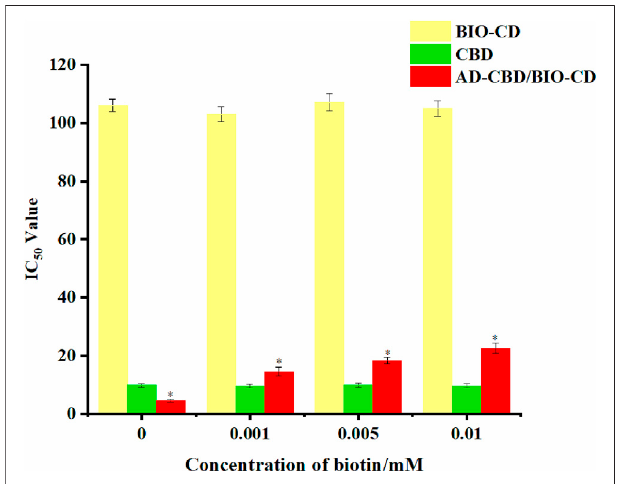
FIGURE 11 | IC 50 values of AD-CBD, BIO-CD, and AD-CBD/BIO-CD towards A549 cell lines under different concentrations of biotin (* p <